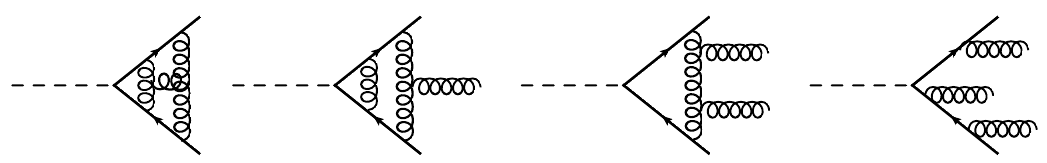
Figure 1 . Representative Feynman diagrams that enter our calculation of H ! bb at O ( (cid:11) 3